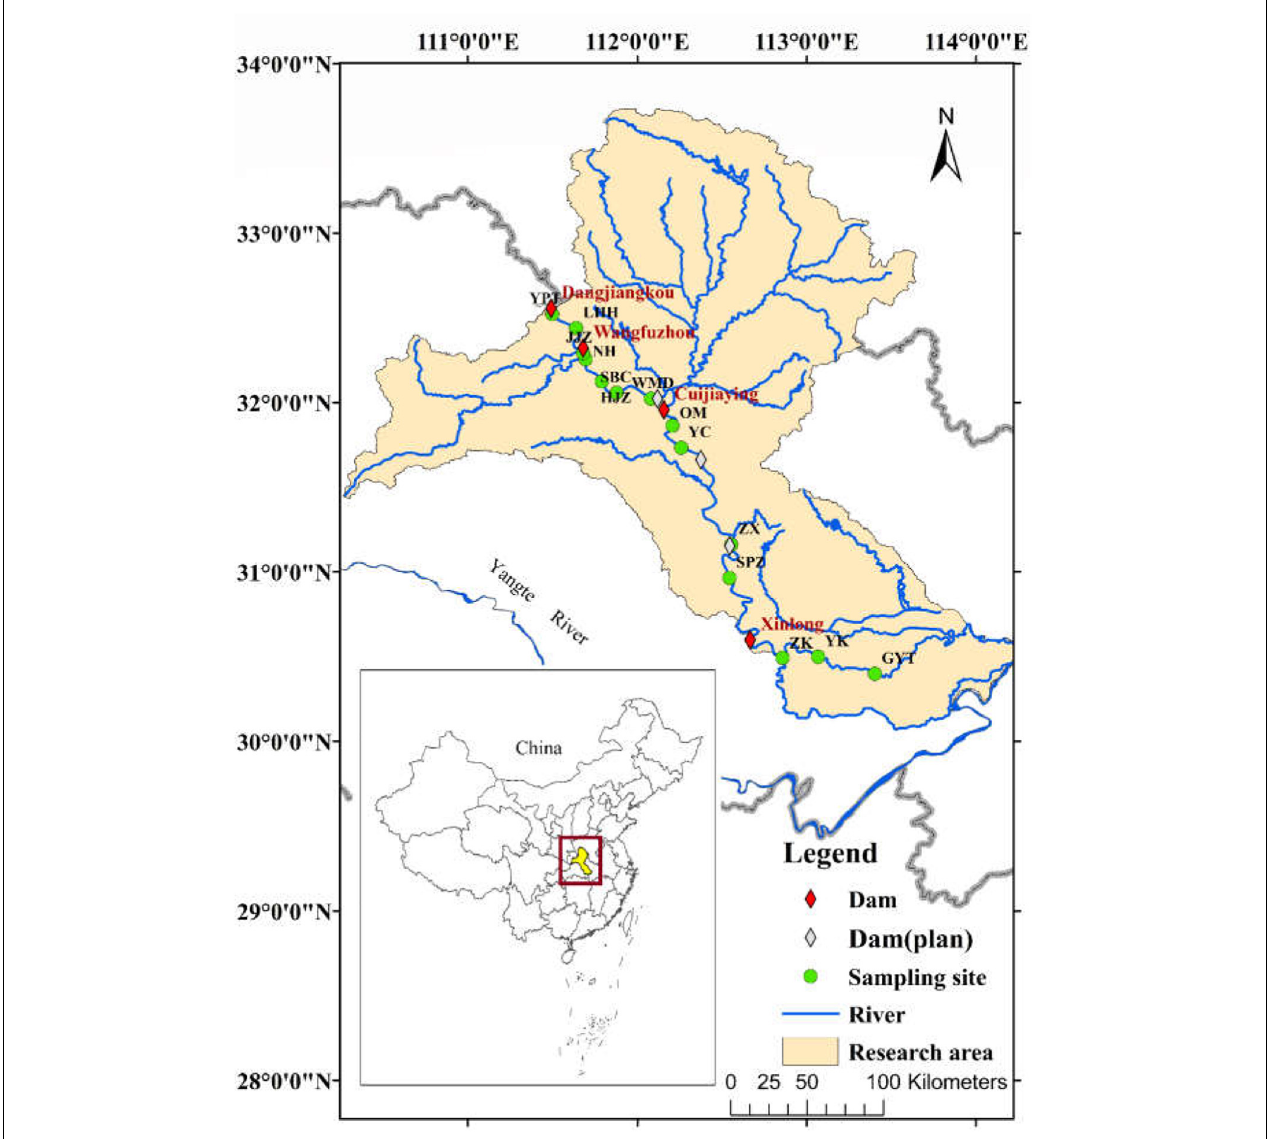
FIGURE 1 | Location of the study area and sampling sites. The sampling sites were named after abbreviations of the local place names: YPT, Yangpitan (B); LHH, Lihuahu (B); JJZ, Jiangjiazhou (B); NH, Nanhu (I); HJZ, Hujiazhou (B); SBC, Shanbiancun (I); WMD, Wumingdao (I); OM, Oumiao (I); YC, Yicheng (B); ZX, Zhongxiang (I); SPZ, Shipaizhen (I); ZK, Zekou (B); YK, Yuekou (B); GYT, Guanyintang (B). Following each sample site, B in parentheses indicates a beach location, and I indicates a central island of the